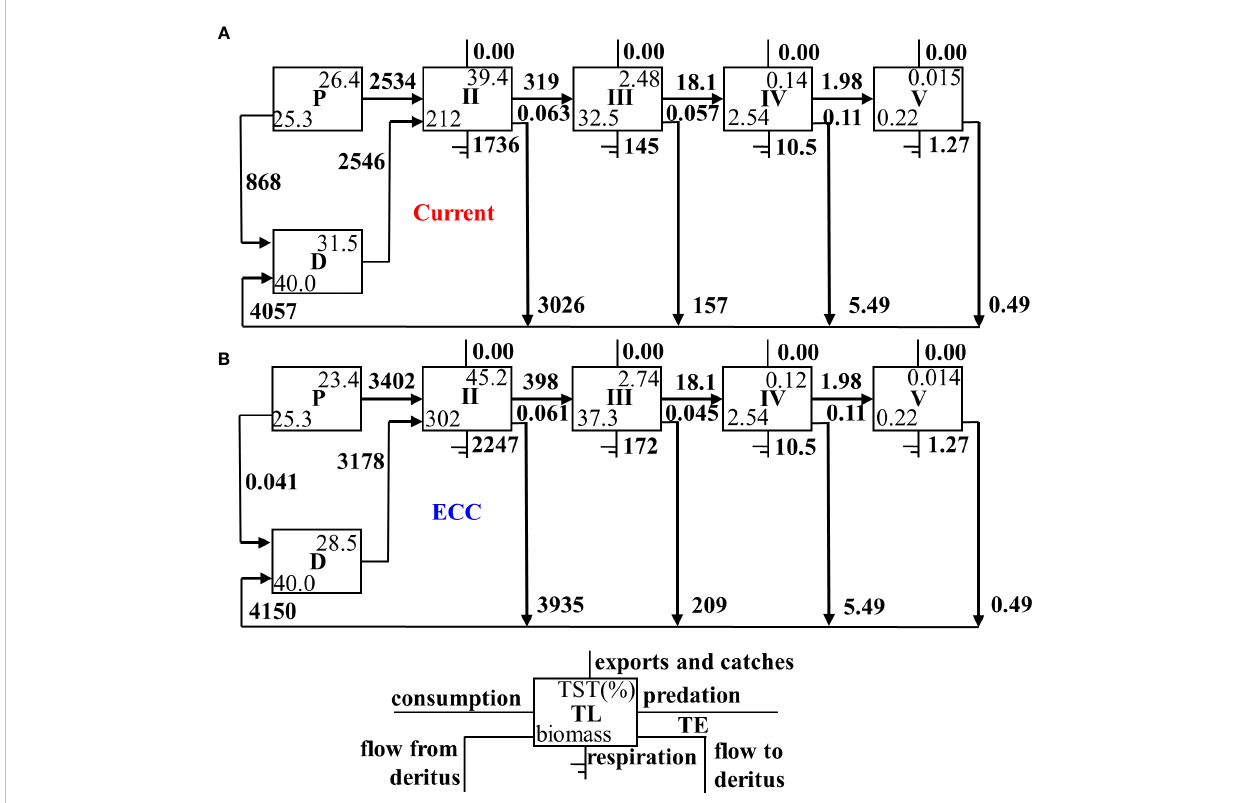
FIGURE 3 Lindeman energy fl ow diagram between trophic levels for two scenarios for (A) current and (B) ECC. ECC, ecological carrying capacity; D, detritus; P, primary producers; TL, trophic level; TE, transfer ef fi ciency; TST, total system